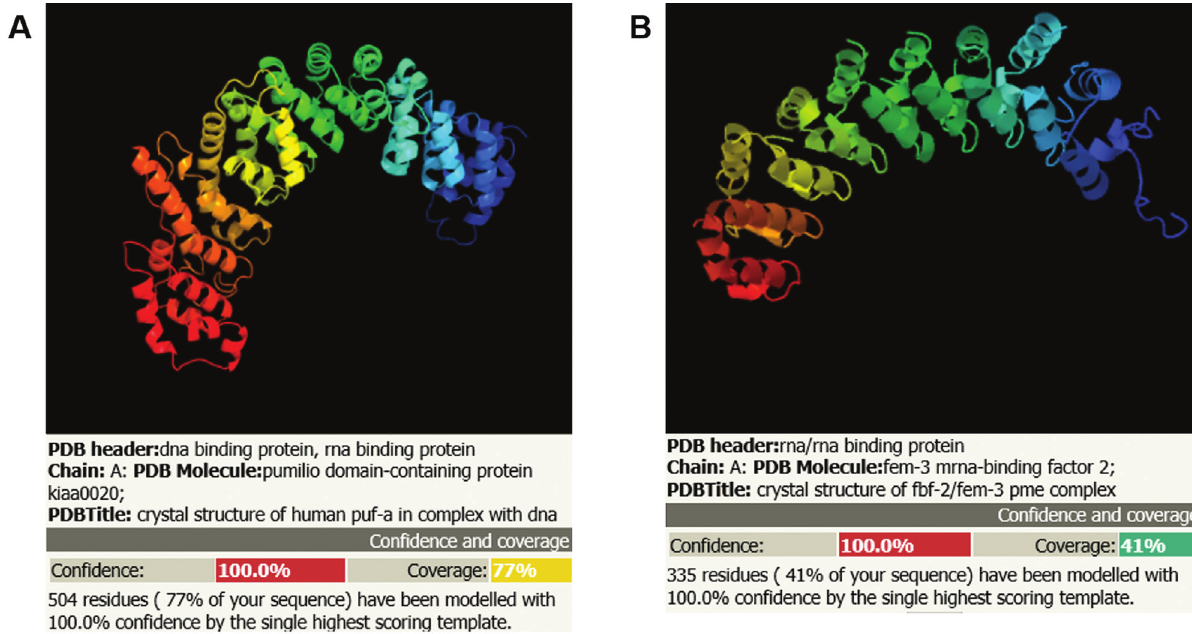
Figure 2 - Structural prediction of ScPuf6 (A) and TcPuf6 (B) proteins (Phyre2